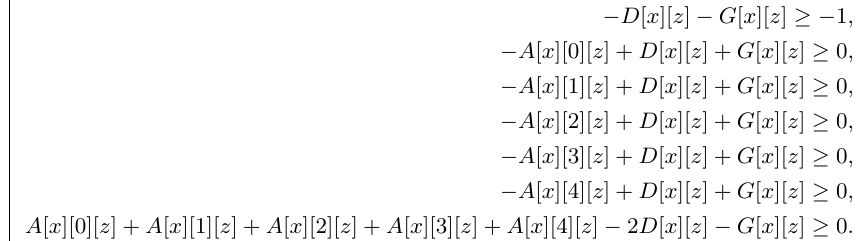
Table 9: Inequalities describing the column parity if the whole column can be placed with cube